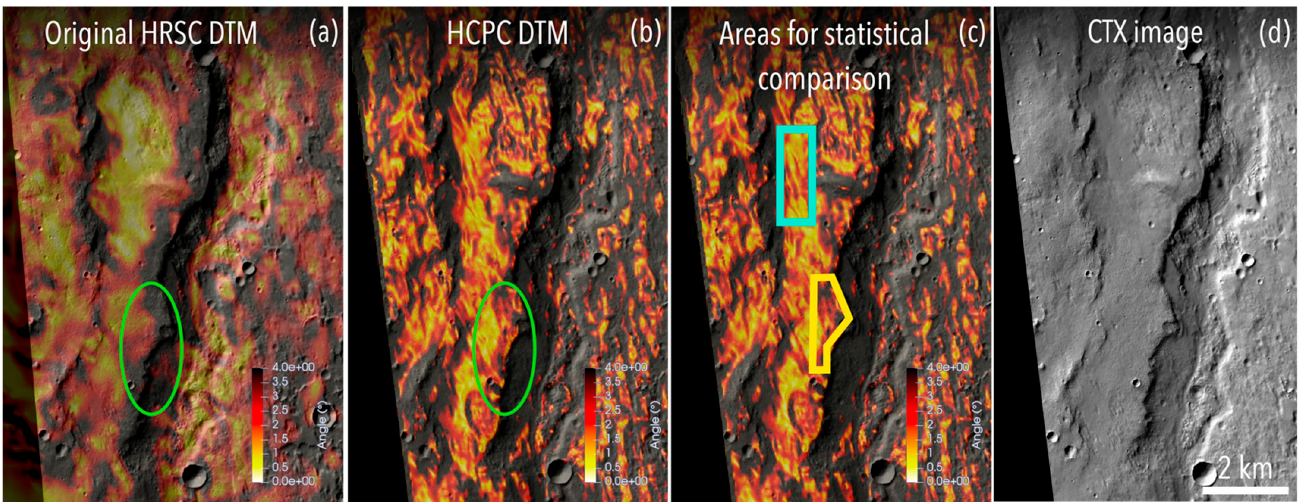
Figure 13. ( a , b ) Comparison of the angles between the facets and the spacecraft for the original HRSC DTM ( a ) and for the HCPC DTM ( b ). ( c ) Outlines of the two areas used for statistical comparison on the northern (cyan) and southern (yellow) plateaus. The southern plateau area geometry was chosen to match the calculations of the potential origin of the reflector (Figure 10). Both areas are about 1.5 km 2 . ( d ) CTX image for context. The angles are shallower in the refined DTM in the area where the reflector is thought to come from (circled in green).